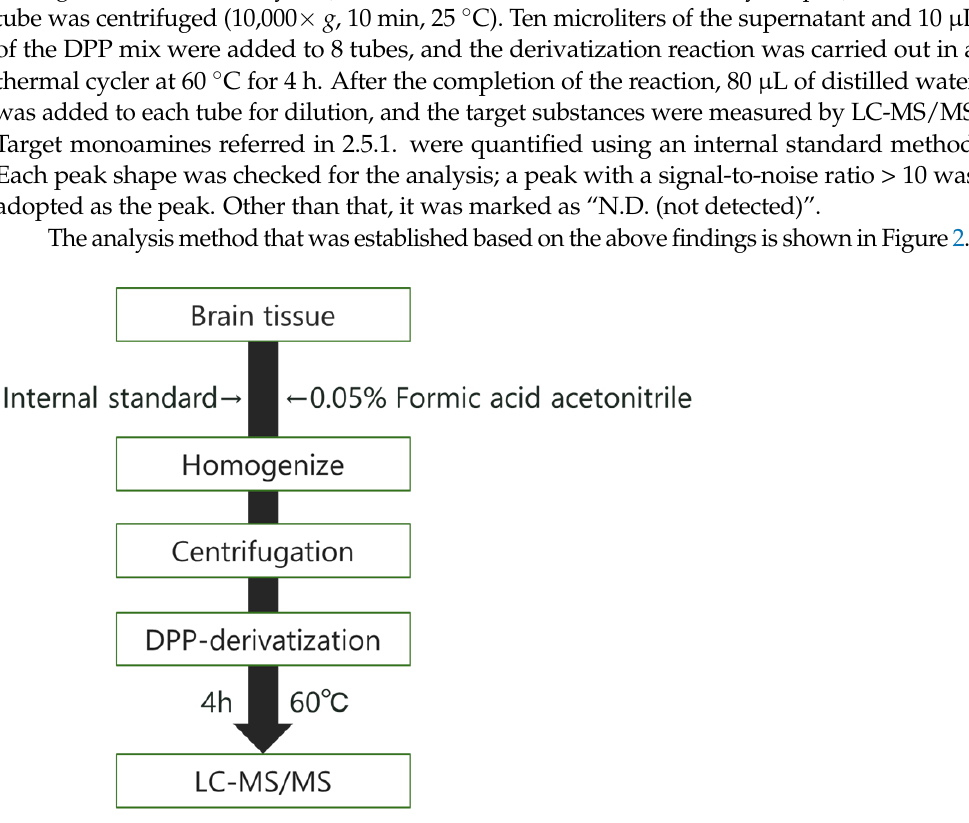
Figure 2. Analytical procedure of DPP-derivatization. DPP, Tetrafluoroborate salt of 2,4-diphenyl- pyranylium; LC-MS/MS, Liquid chromatography-tandem mass